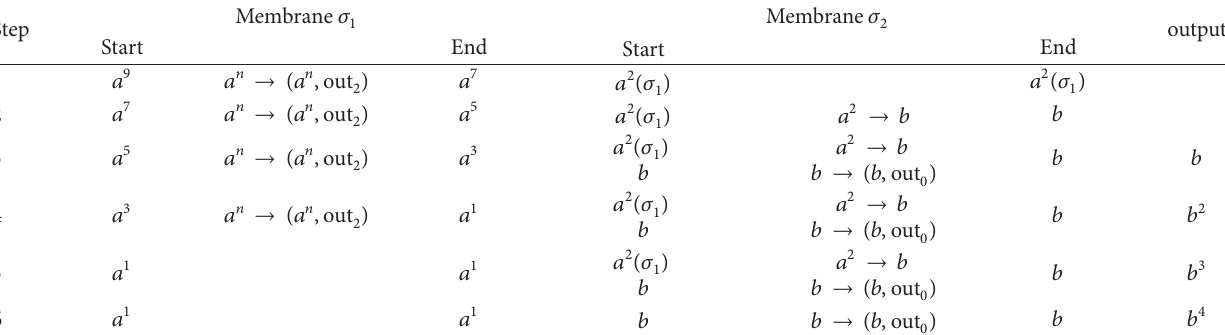
Table 3: The implementation of P chain system for nonexact division